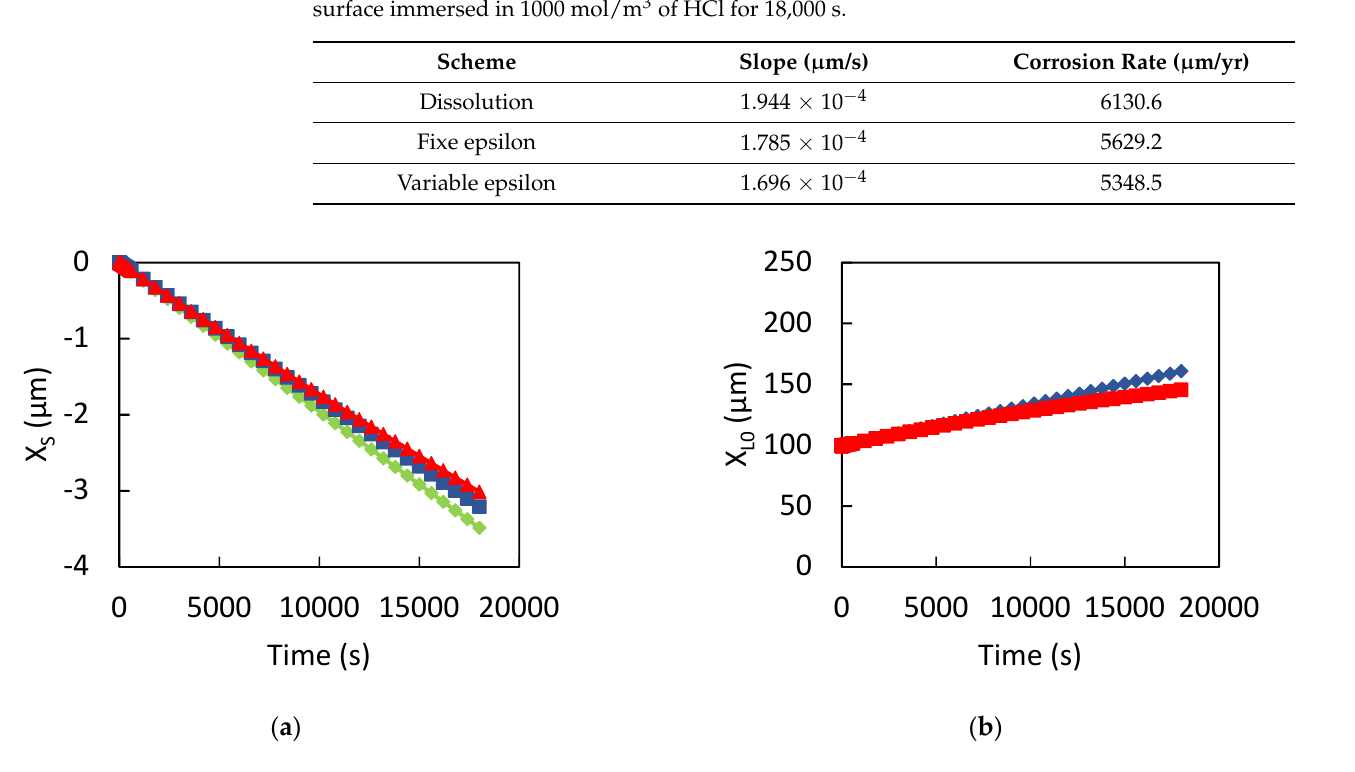
Figure 7. Evolution of ( a ) the position of the electrode surface x s ( µ m) and ( b ) position of CPL electrolyte interface x L0 ( µ m). Simulation with only dissolution (green), a fixed porosity (blue), and a variable porosity (red). Table 2. Extrapolation of the curves in Figure 7a to determine the dissolution kinetics of the lead surface immersed in 1000 mol/m 3 of HCl for 18,000 s.